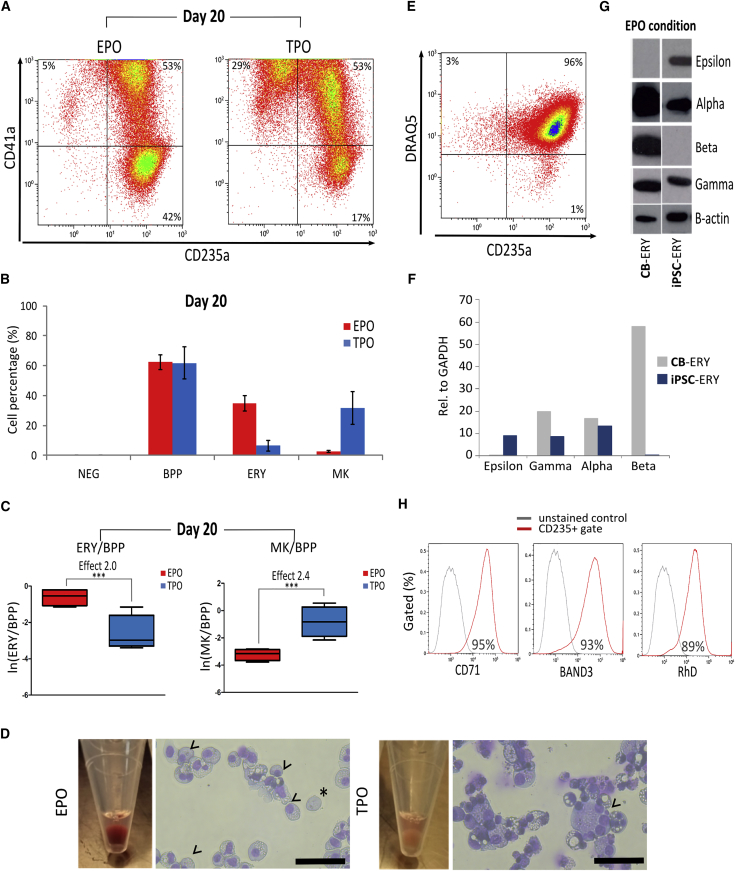
Maturation of the Forward Programmed hPSCsDay 9 FoP cells were further cultured in suspension in EPO or TPO conditions and cell differentiation analyzed at day 20 post-transduction.(A) Representative flow cytometry dot plots for CD41a and CD235a expression.(B) Percentages of cells belonging to the undifferentiated NEG (CD41a−/CD235a−), BPP (CD41a+/CD235a+), ERY (CD41a−/CD235a+), and MK (CD41a+/CD235a−) populations, respectively, in the different culture conditions (n = 4, mean ± SEM); EPO culture (red bars), TPO culture (blue bars).(C) Boxplots over sets of four replicates of the log(e) of the number of ERYs (left plot) and MKs (right plot) over the number of BPPs as detected by flow cytometry. The log odds of cells being ERY or MK (mean effect) rather than BPP were strongly associated with cytokine exposure and were 2.0 (ERY in EPO) and 2.4 (MK in TPO) (∗∗∗p < 0.001).(D) Pictures of day 20 cell pellets from representative EPO (left) and TPO (right) cultures and cell morphology analyzed by Giemsa staining. Cytospins show normoblasts with condensed eccentric nuclei (arrowheads) and an enucleated reticulocyte (asterisk) from the EPO (left) culture and large polyploid MKs (arrowheads) from the TPO (right) culture. Scale bar, 50 μm.(E) Representative flow cytometry dot plot of day 20 cells analyzed for expression of CD235a and the nuclear staining DRAQ5. Enucleated reticulocytes (bottom right quadrant) represent only a single-figure percentage of the whole-cell population.(F) RNA was extracted from day 20 forward-programmed cells (iPSC-ERY) and cord blood-derived erythroblasts (CB-ERY) and analyzed by qRT-PCR to quantify the expression of the ε-, γ-, α-, and β-globin chains (n = 1).(G) Whole-cell extracts were analyzed for ε-, γ-, α-, and β-globin content by western blotting. The left panels represent the results from cell lysates of CB-ERY and the right panels those from iPSC forward-programmed erythroblasts (iPSC-ERY); β-actin was used as protein loading control (n = 1).(H) Representative flow cytometry histograms of CD71, BAND3, and RhD expression in CD235a+-gated cells from the EPO cultures; isotype control (gray line) and stained cells (red line).